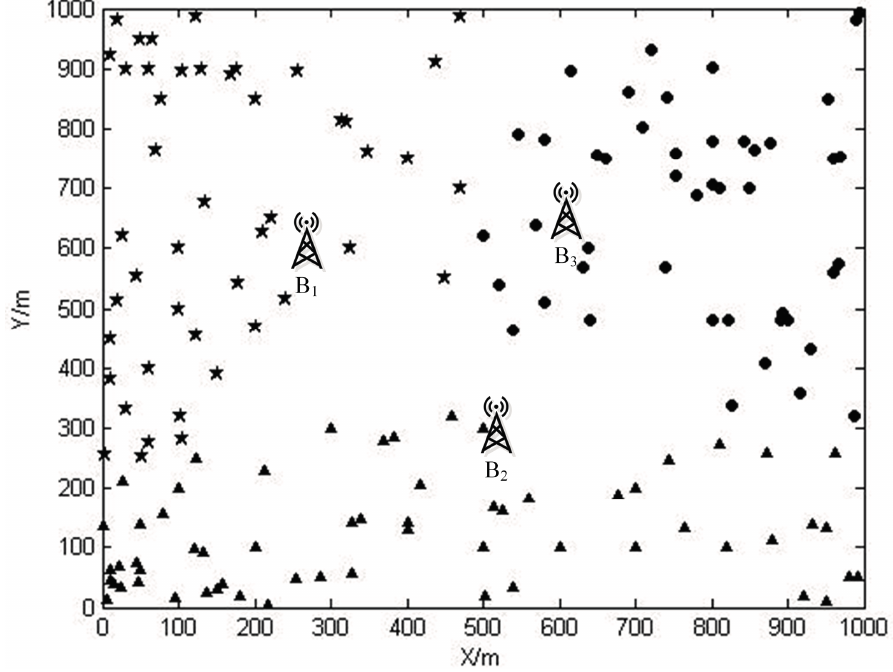
Figure 7. Network partition via Voronoi diagram.